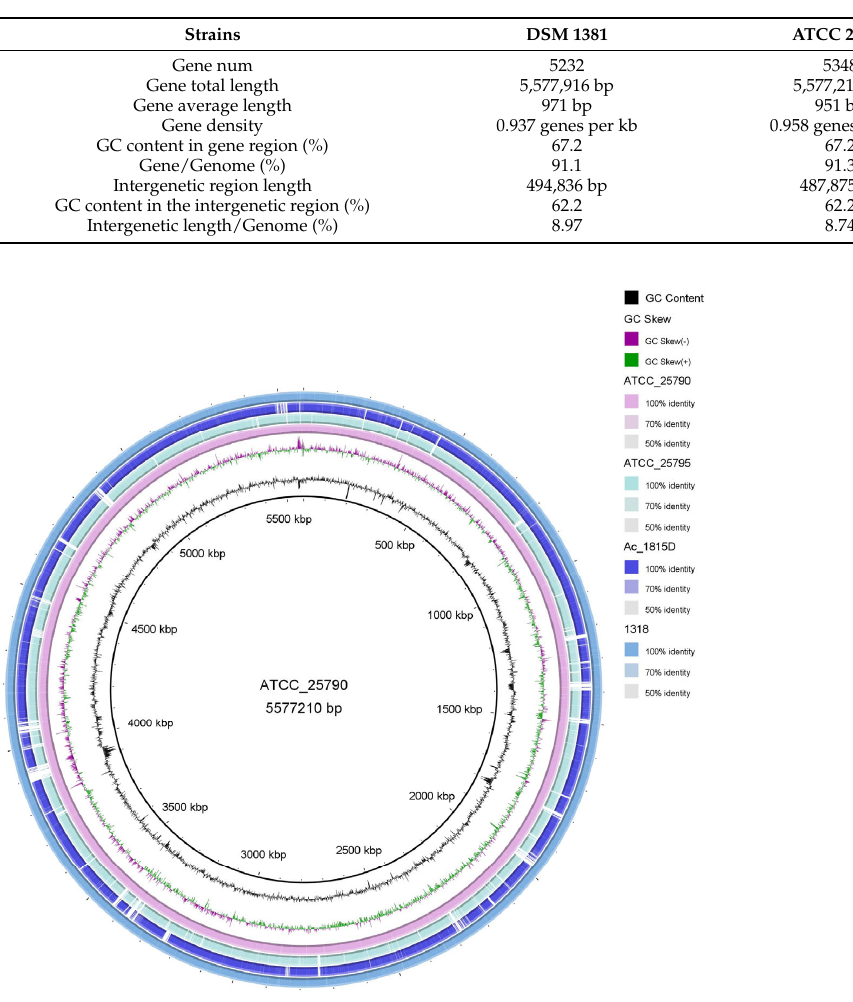
Table 1. Results of genome sequencing and gene annotation.